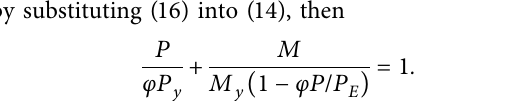
Figure 9: Stress distribution of web of stubs corresponding to ultimate capacity under different &epsi; : (a) Q460; (b) Q690; (c) Q800; and (d)